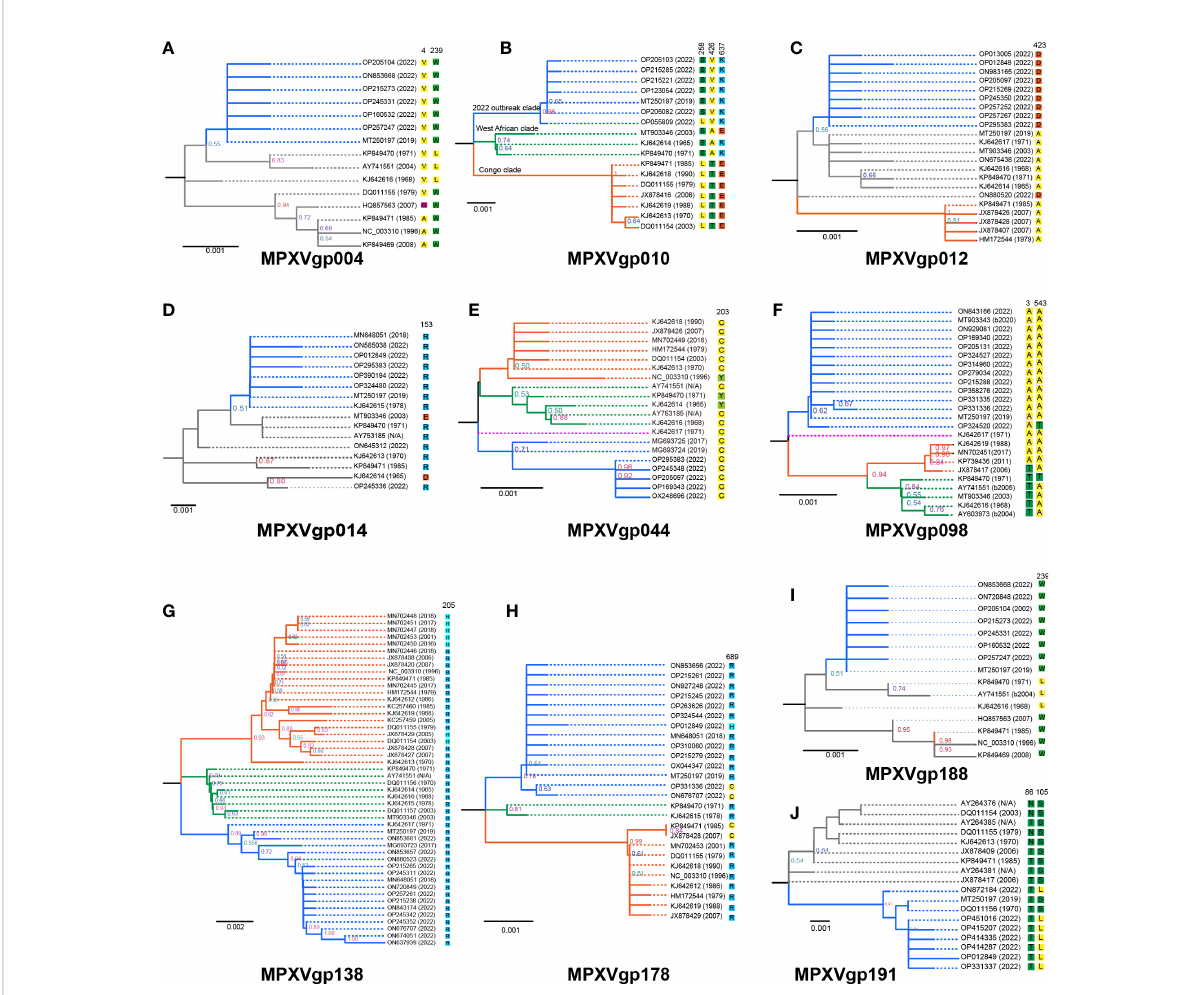
FIGURE 4 Phylogeny of MPXV genes evolved under positive selection at the codon level and amino acids at the positive selection sites in the 10 MPXV genes. Those genes that were identi fi ed as positively selected genes at the codon level include (A) MPXVgp004, (B) MPXVgp010, (C) MPXVgp012, (D) MPXVgp014, (E) MPXVgp044, (F) MPXVgp098, (G) MPXVgp138, (H) MPXVgp178, (I) . MPXVgp188, and (J) MPXVgp191. Interior branch numbers represent bootstrap values and are indicated when the values are greater than 0.5. Allele names were marked as their representative isolate names, shown as GenBank accession numbers, and the